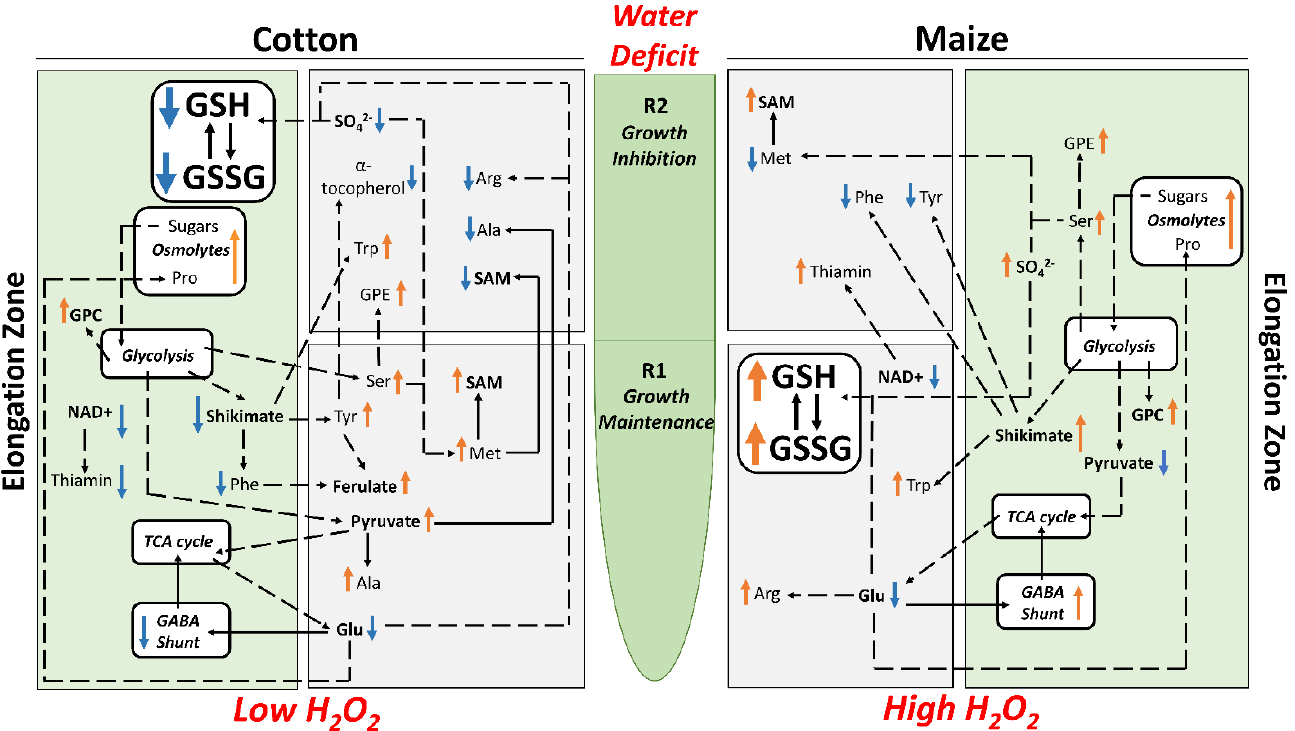
Figure 9. Summary of key changes in metabolite abundance in R1 and R2 and the whole elongation zone of cotton ( left panels) and maize ( right panels) primary roots growing under water deficit conditions with a focus on metabolites related to osmotic adjustment, antioxidative metabolism, sulfur metabolism and ultimately growth. Arrows adjacent to the metabolites indicate increases (orange) or decreases (blue) in abundance in water-stressed compared with well-watered roots.